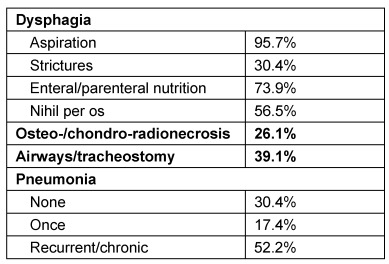
Indications for total laryngectomy in patients with laryngo-pharyngeal dysfunction according to Hutcheson [263] – complications and functional disorders